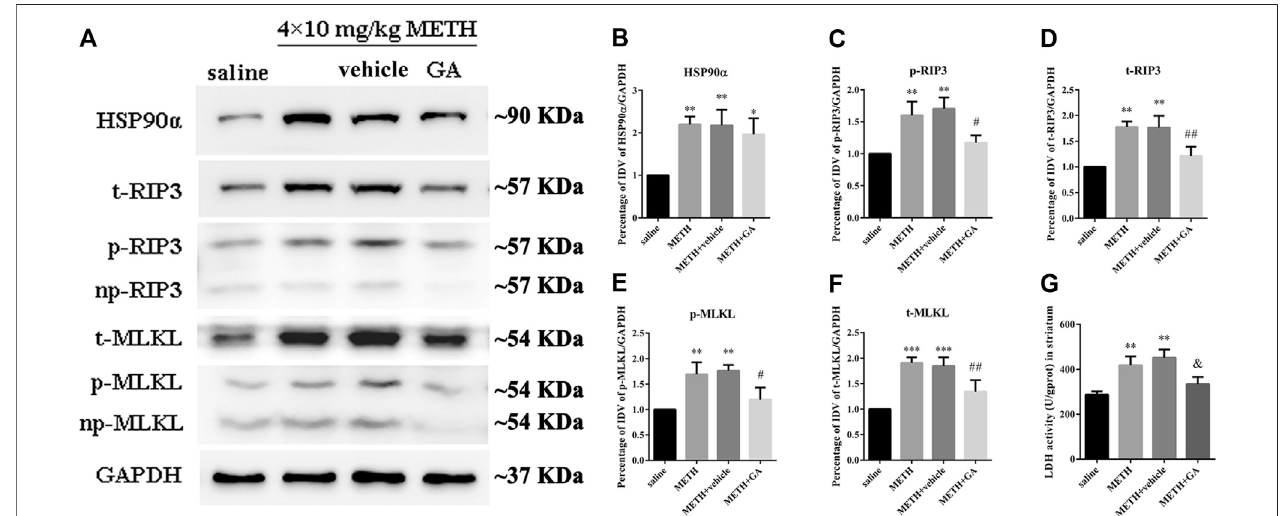
FIGURE 9 | HSP90 α inhibition by brain stereotactic injections of GA attenuated the METH/HT-induced upregulation of RIP3, p-RIP3, MLKL, and p-MLKL and the LDH activity in the rats ’ striatum following a binge dose of METH. (A) WB of HSP90 α , RIP3, p-RIP3, MLKL, and p-MLKL following a binge dose of METH administration and pre-treatment with GA by brain stereotactic injections. (B – F) Statistical analysis of WB of HSP90 α , RIP3, p-RIP3, MLKL, and p-MLKL expression. Data were analyzedbyone-wayANOVA, followedbyaTukeymultiplecomparisonsposttest( n (cid:2) 3).* p < 0.05,** p < 0.01,*** p < 0.001vs.salinegroup;# p < 0.05,## p < 0.01 vs. METH group. (G) Necrosis in the striatum of rats was determined by LDH cytotoxicity assay. Data were analyzed by one-way ANOVA, followed by a Tukey multiple comparisons posttest ( n (cid:2) 3). ** p < 0.01 vs. saline group; & p < 0.05 vs. METH group.